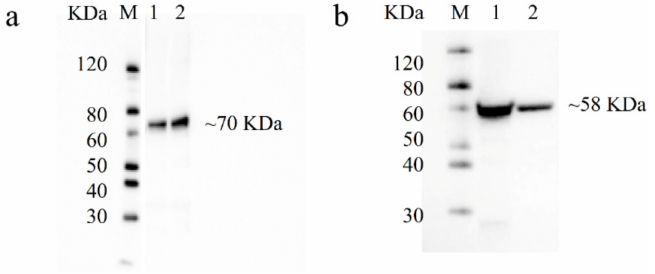
Figure 3. Western blot analysis of recombinant PhGDH1 ( a ) and PhGDH2 ( b ). M: protein ladder; 1–2: purified PhGDH1/PhGDH2 fusion proteins.